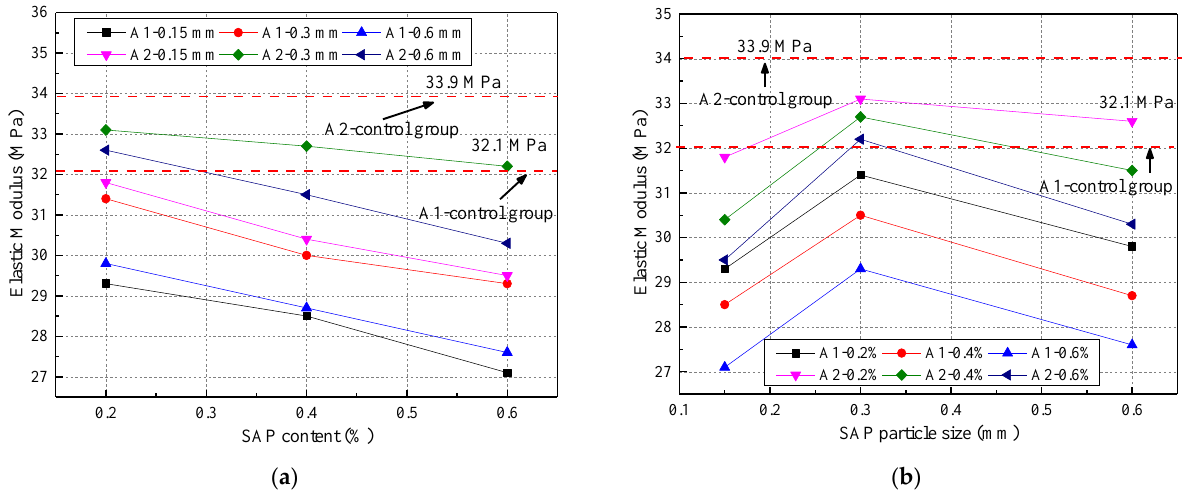
Figure 7. Elastic modulus of concrete under two water–cement ratios: ( a ) different SAP content; ( b ) different SAP particle size.